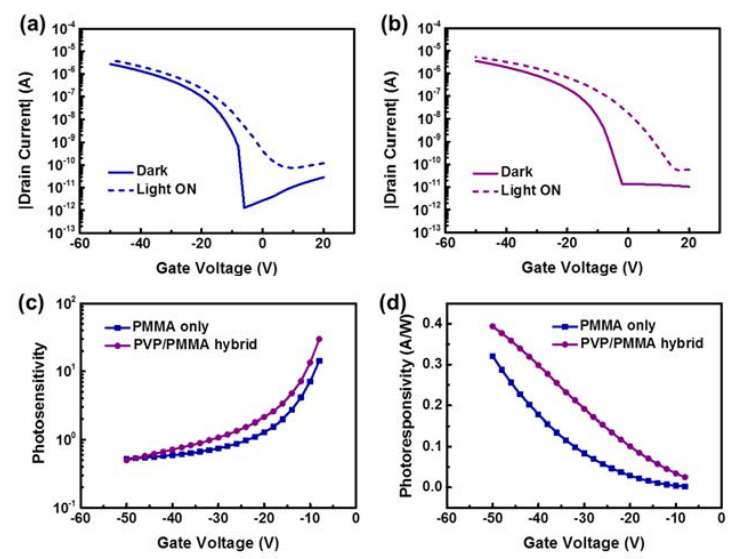
Figure 3. Transfer curves for the OPT with the ( a ) single-polymer PMMA gate insulator, and ( b ) hybrid PVP / PMMA gate insulator in the UV-exposed and non-exposed states. ( c ) Photosensitivity and ( d ) photoresponsivity of the devices as a function of gate voltage.